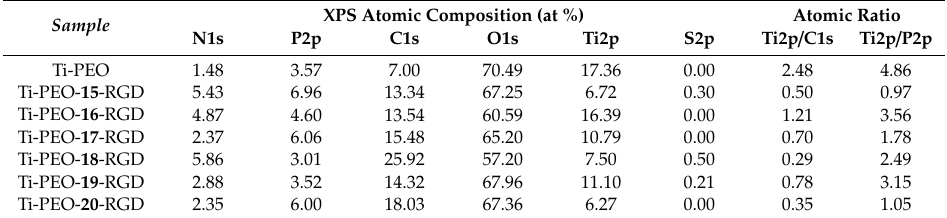
Table 1. Atomic composition and atomic ratio derived from XPS high-resolution spectra for the Ti-PEO samples with and without RGD